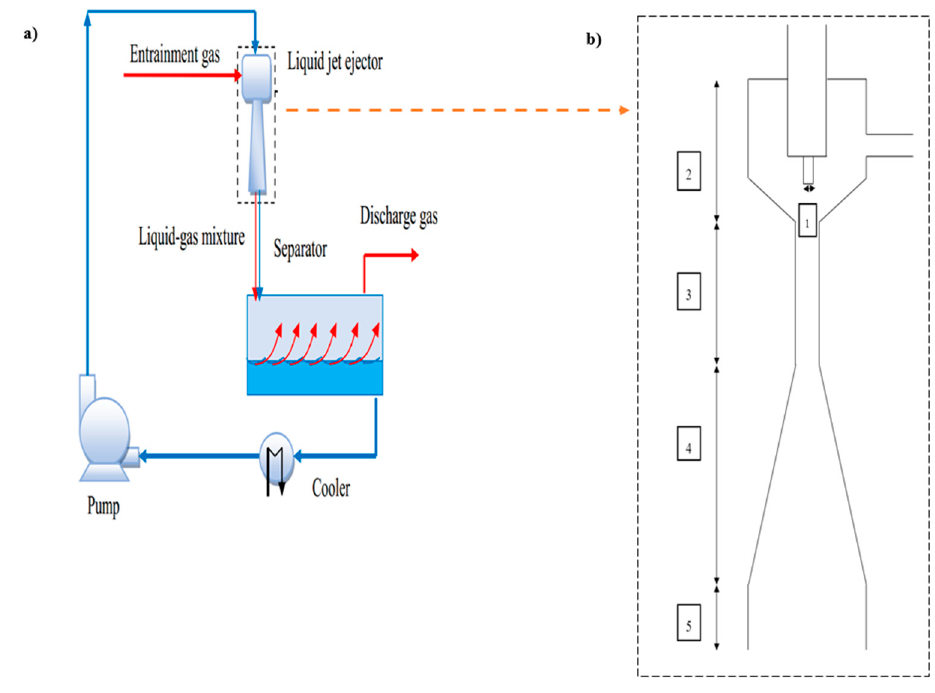
Figure 1. ( a ) The schematic of a flare gas recovery system, ( b ) the typical geometry of a liquid jet